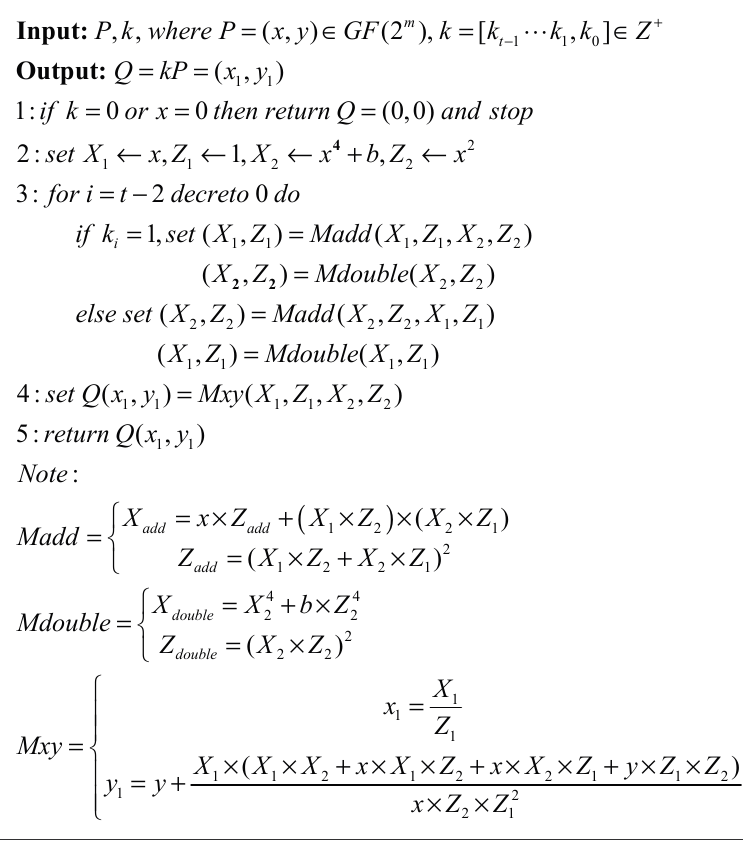
Algorithm 3. Montgomery ladder algorithm in López-Dahab